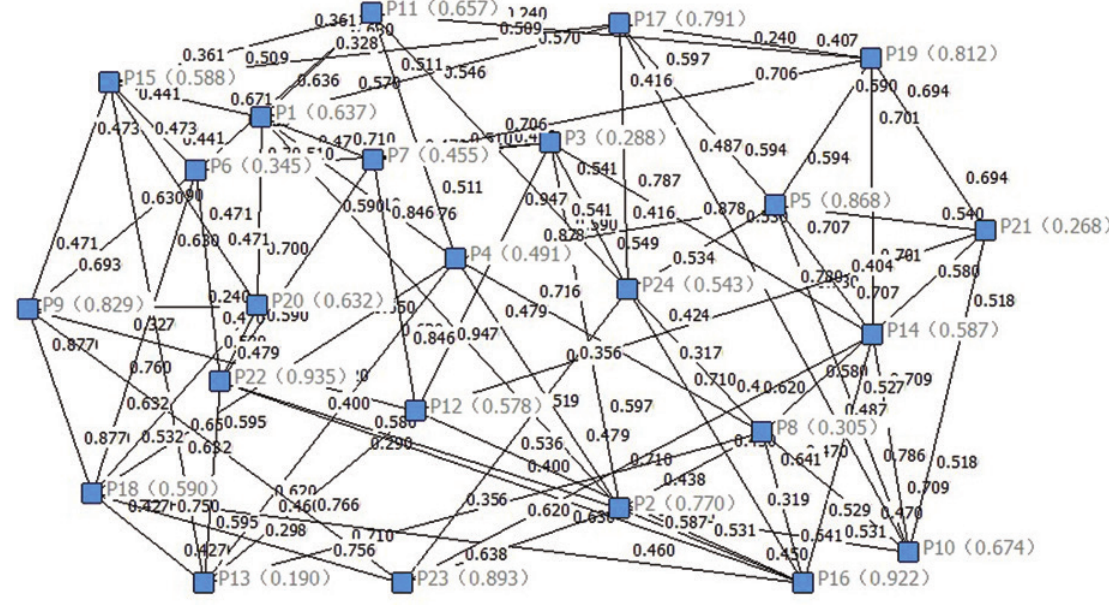
Figure 4: Weighted Social Network of Candidates.